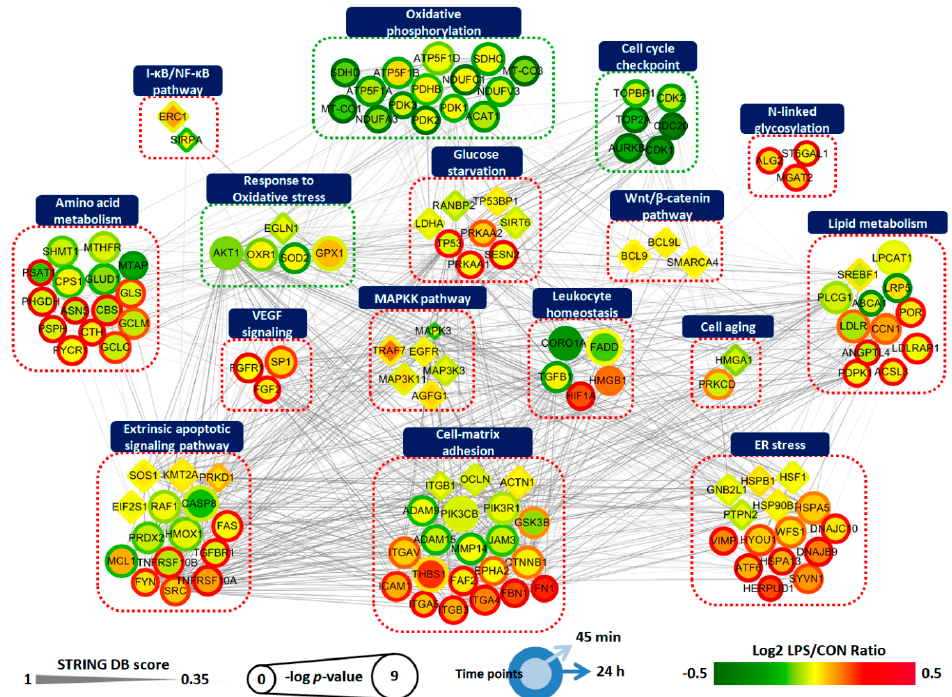
Figure 5. Network analysis of proteins related to inflammation-driven pathology of ARPE-19 cells. A total of 136 differentially expressed proteins and phosphoproteins involved in differentially regulated biological processes were grouped according to their function. Circle indicates DEP and diamond indicates DPP. Node colors represent an increase (red) and decrease (green) in LPS-treated ARPE-19 cells for 45 min (center) and 24 h (boundary) compared to untreated controls. The color bar represents the gradient of log2 protein ratios. The size of a node represents –log10( p -value). The edges represent PPIs obtained from the STRING database [28]. Pathways with red dotted lines indicate clusters upregulated by LPS and pathways with green dotted lines indicate clusters downregulated by LPS. All are indicated by gene